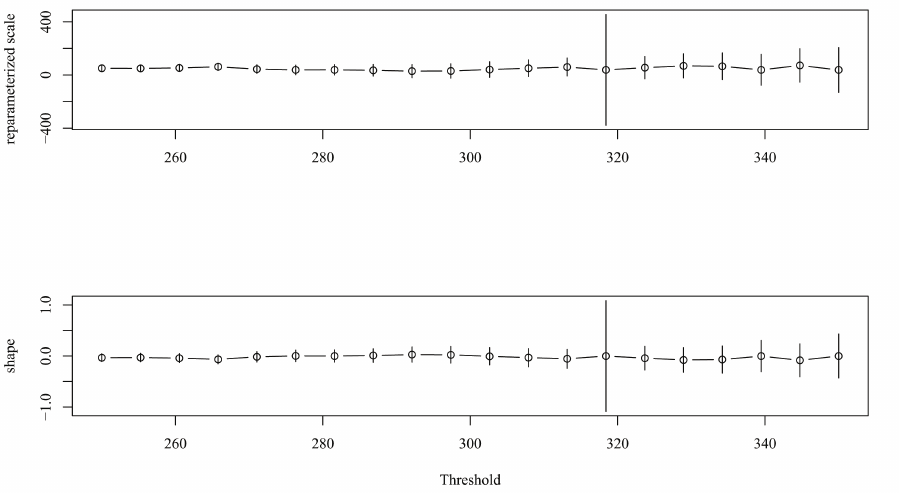
Figure 6. Estimates of two parameters for different thresholds, and an approximately linear relation- ship exists in the interval [250, 300].